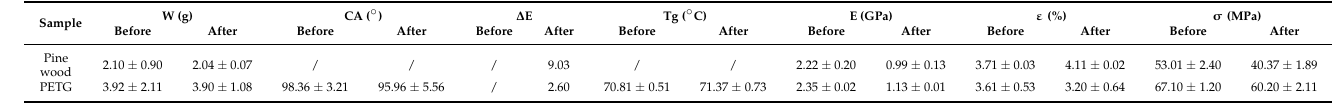
Table 1. Comparison of surface, thermal, and mechanical properties of pine wood and PETG before and after artificial